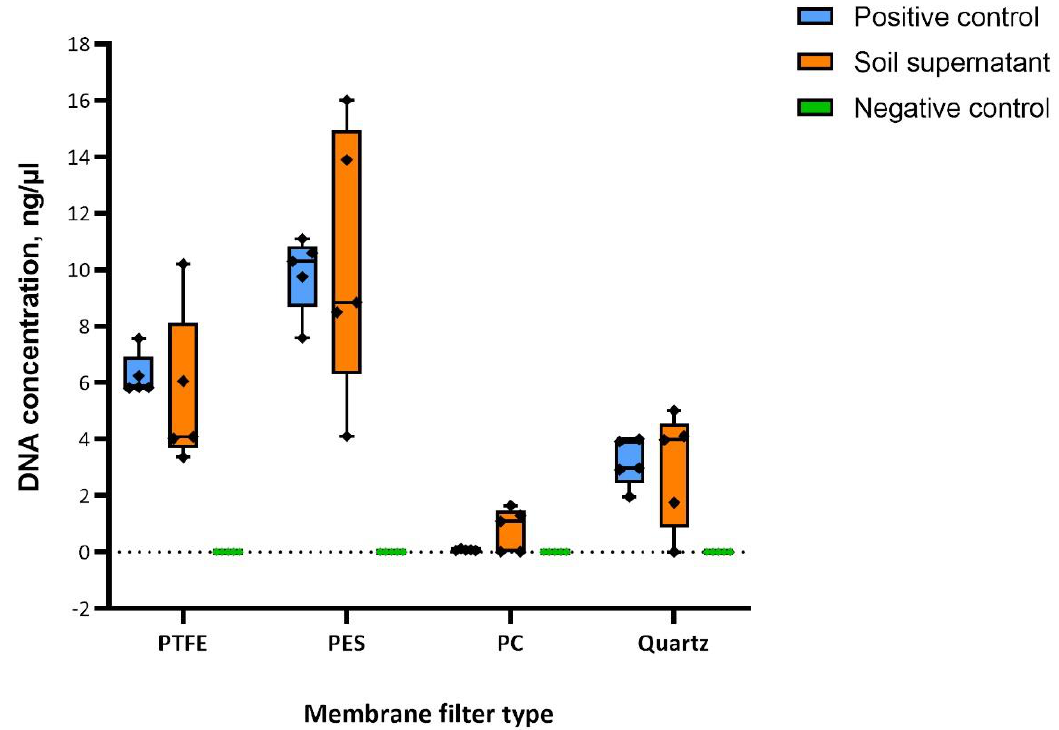
Figure 4. Results of bioaerosol chamber sampling experiments. The boxplot represents five biological replicates ( n = 5) for each membrane filter type. Yeast cells were used as a positive control whose mass was constant with each replicate, and varying biomass of soil supernatant was used to validate the consistency of the filter efficiency. The graph was plotted using Prism 9. Error bars indicate the mean with standard deviation.